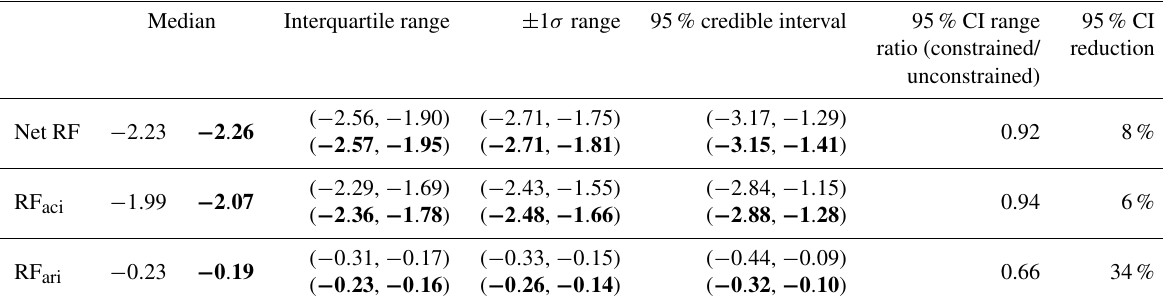
Table 3. Uncertainty distribution statistics (median, interquartile range, ± 1 σ range (on mean value) and 95% credible interval) for the global annual mean aerosol radiative forcing (net RF, RF aci and RF ari ) from the unconstrained sample of 1 million model variants in normal font and the constrained sample of model variants from the all-variables constraint in bold. The final two columns show the ratio of the constrained to the unconstrained 95% credible interval and corresponding percentage reduction in this interval on